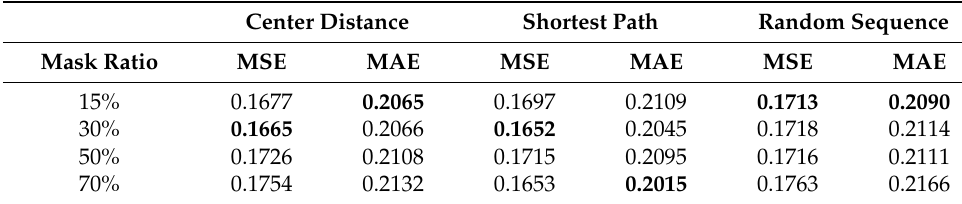
Table 15. Ablation over different masking strategies.